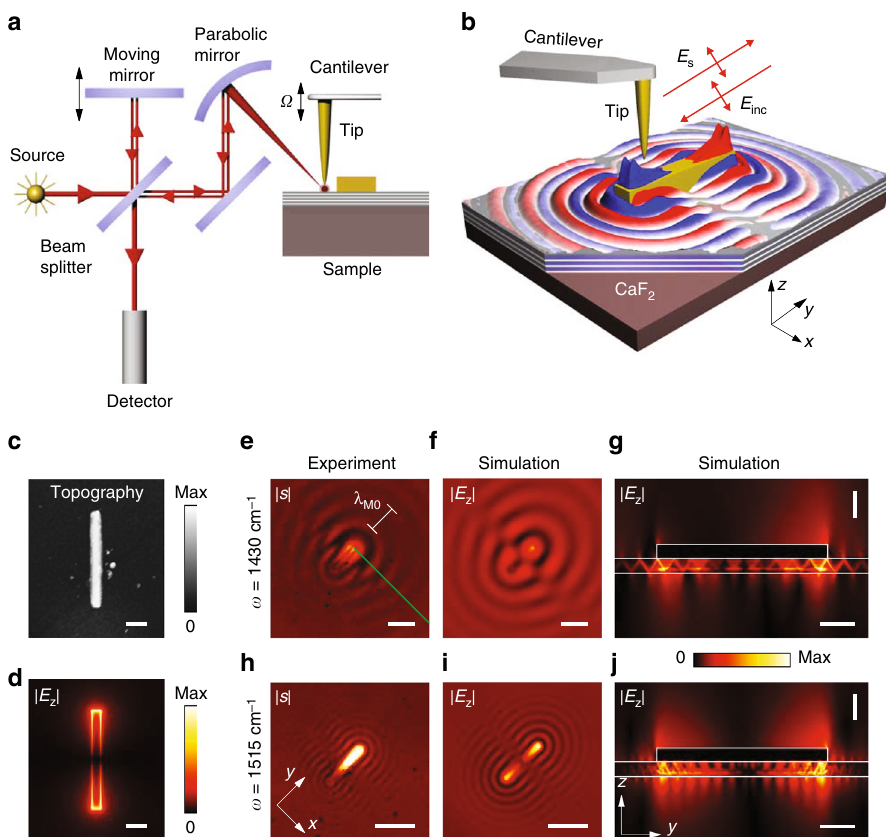
Fig. 4 Near- fi eld imaging of the HPhPs launched by the gold antenna. a Schematics of the s-SNOM setup. b Illustration of antenna launching of HPhPs. The spatial distribution of the near- fi eld (shown by the red and blue colors) is adapted from the simulation of Re( E z ). c Topography of the antenna. d Simulated near- fi eld distribution, | E ( x , y )|, created by the rod antenna on CaF 2 (the fi eld is taken at the top surface of the antenna). Scale bars in c , d are 0.5 μ m. e , h Experimental near- fi eld images. f , i Simulated near- fi eld distribution |E z ( x , y )| (taken 150 nm away from the h-BN slab). g , j Simulated near- fi eld distribution |E z ( z , y )| taken in the cross-section plane along the center of the rod antenna. In e – g ω = 1430 cm − 1 , while in h – j ω = 1515 cm − 1 . The scale bars in e – i are 2 μ m and in g , j are 0.1 μ m (vertical) and 0.5 μ m (horizontal). The length of the antenna in all panels is L = 2.29 μ